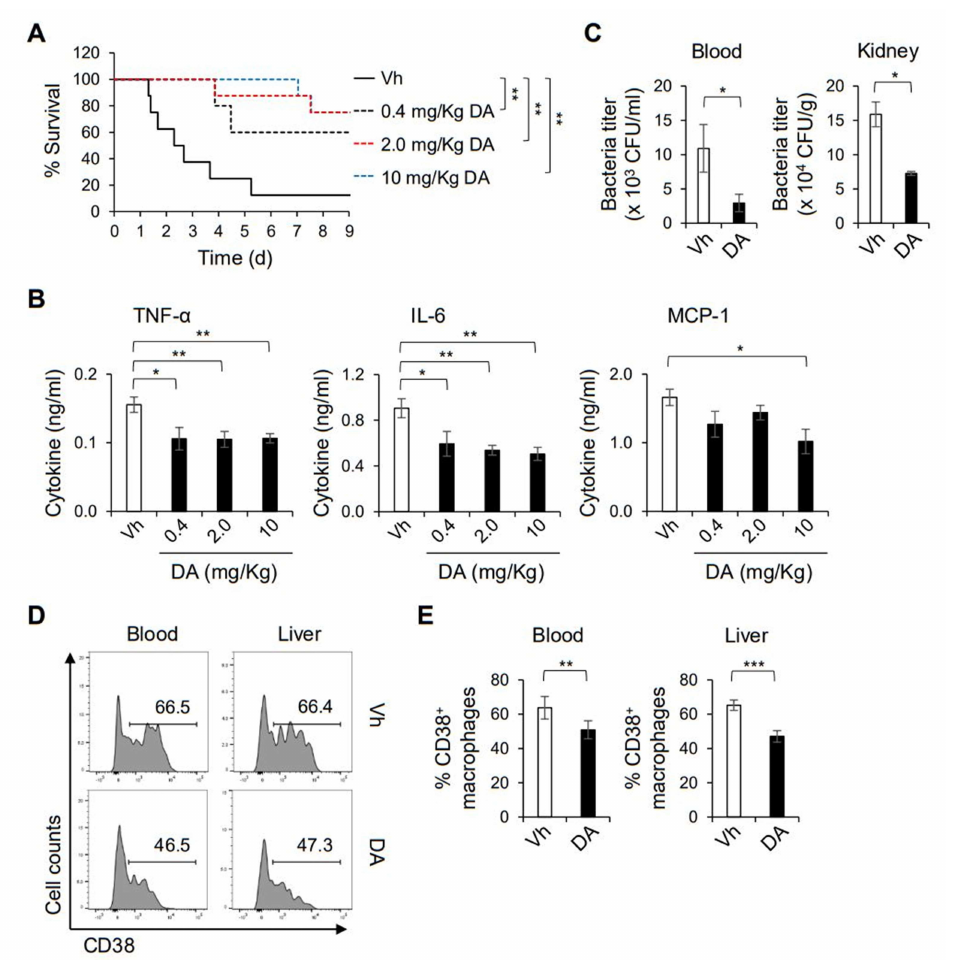
Figure 3. DA mitigates sepsis induced by methicillin-resistant S. aureus infection. ( A ) Mice were intraperitoneally pretreated with the indicated doses of DA three times and intravenously infected with 1 × 10 8 CFU MRSA. A Kaplan–Meier plot is shown; n = 8. ( B ) Amounts of TNF- α , IL-6 and MCP-1 in the plasma were measured by CBA. ( C ) Bacterial titers in the blood and kidney were determined by colony-forming assay 8 h after MRSA infection; n = 6. ( D , E ) Macrophage population in the blood and liver was analyzed by flow cytometry 8 h after MRSA infection. Representative histograms with the frequencies of the CD38 + cells in the CD11b + F4/80 + gates ( D ) and the mean ( ± S.D) frequency of CD38 + macrophages ( E ) are shown; n = 5; * p < 0.05, ** p < 0.01, *** p <